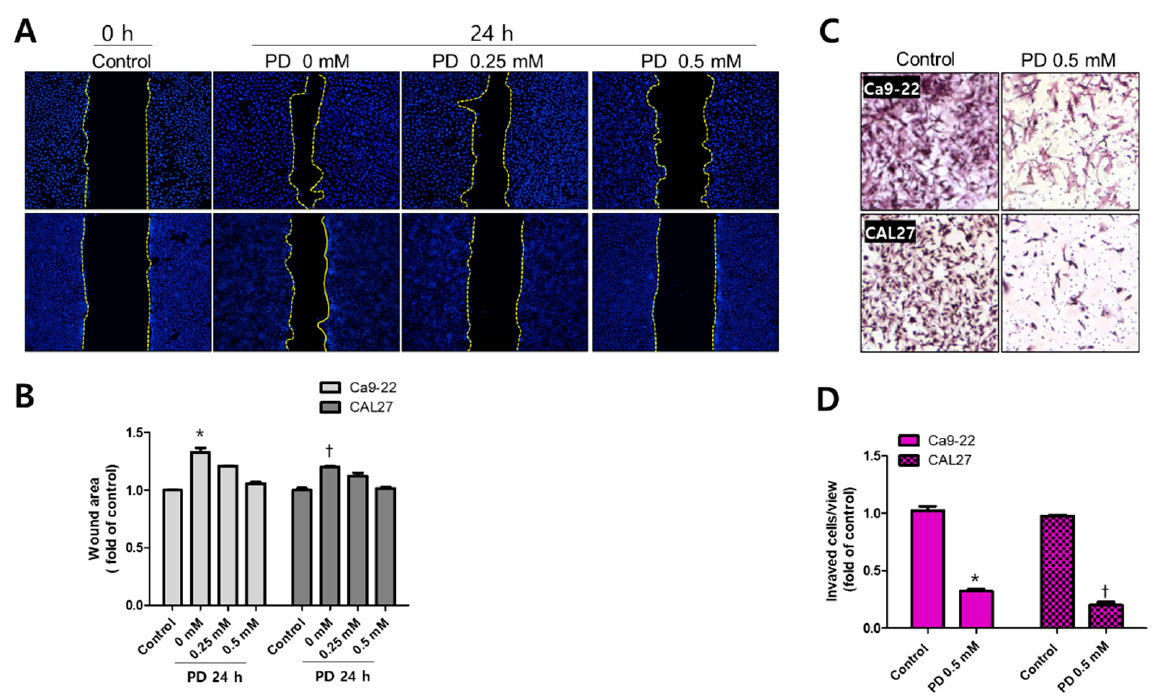
Figure 5. Inhibition of cell migration and invasion by polydatin in OSCC cells. ( A ) Ca9-22 and CAL27 cells seeded in a six-well plate were scratched and then treated with 0, 0.25, and 0.5 mM polydatin; the cell migration distance was measured through Hoechst staining 24 h later. ( B ) The wound healing rates in the two cell lines were measured and graphed. Wound width was calculated and analyzed using the ImageJ software. ( C ) Ca9-22 and CAL27 cells were seeded in a transwell membrane and treated with 0.5 mM polydatin for 48 h; the invading cells were stained with H&E. ( D ) The number of invading cells was determined and graphed. Results are expressed as mean ± SD. Data were derived from three independent experiments. (Ca9-22: * p < 0.05; CAL27: † p < 0.05).